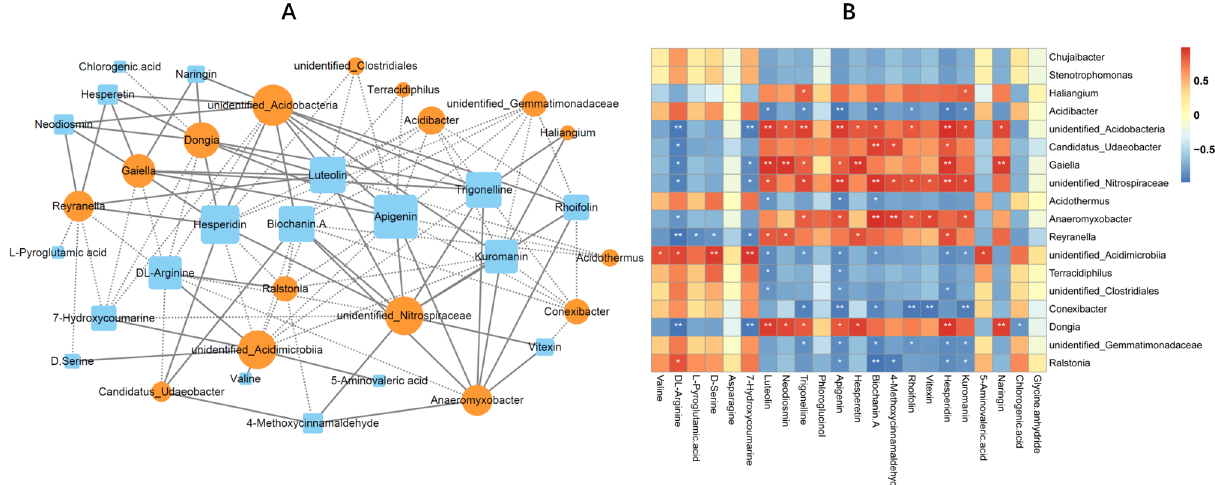
Figure 5. Integrated correlation-based network analysis of the soil microbes and sugarcane metabolites. ( A ) Correlation-based network analysis (Pearson’s correlation) of microbes and metabolites (solid line and dotted line representing positive correlation and negative correlation, respectively). ( B ) Pearson’s correlation analysis from the entire network between 18 differential microbes and 22 distinct metabolites showed in the heatmap (positive correlation in red, negative correlation in blue; * P < 0.05, ** P < 0.01). Figures were produced using R (v3.4.3, https ://www.R-proje erated by calculating the Pearson’s correlation coefficient between the different bacterial abundances (18 genera) and distinct metabolites (22 compounds mainly involved in the flavonoid biosynthesis pathway, VIP > 1.0) of the BS and SS groups (Table S7). Significant associations were selected ( P < 0.05), and their biological networks were visualized using Cytoscape v3.7.1, based upon which clear correlations were identified between the perturbed soil microbiome and altered metabolite profiles (Fig. 5). As expected, the composition of the soil microbiome was widely associated with the sugarcane metabolic content. At a 5% false discovery rate (FDR), we found 108 associations between sugarcane metabolites and microbial species (Fig. 5A). In particular, 88.9% of the spe-